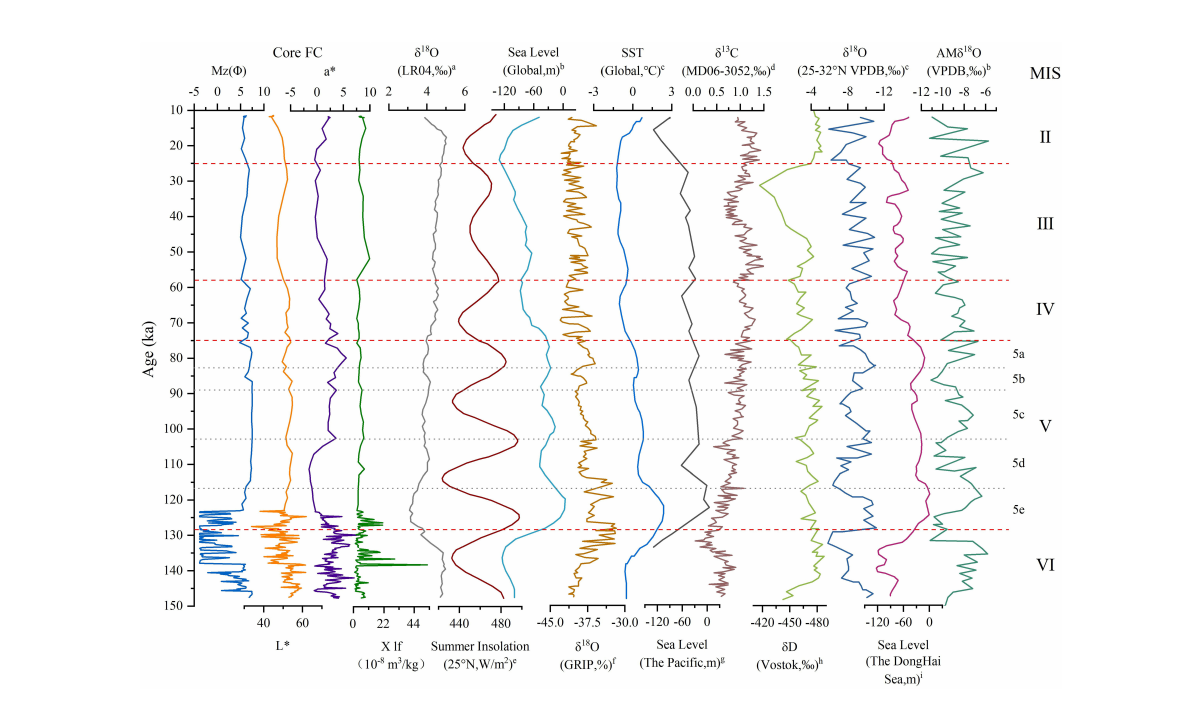
FIGURE 8 Response of substitutive indexes of borehole sediments from FC borehole in Middle and Late Pleistocene to climate and sea level changes records. The geological record curves separately from: Lisiecki and Raymo, 2005 (a); Cheng et al., 2016 (b); Moseley et al., 2021 (c); Guo, 2015 (d); Yuan et al., 2004 (e); Linsley, 1996 (f); Qiu, 2013 (g); Lea, 2000 (h); Zhuang, 2002